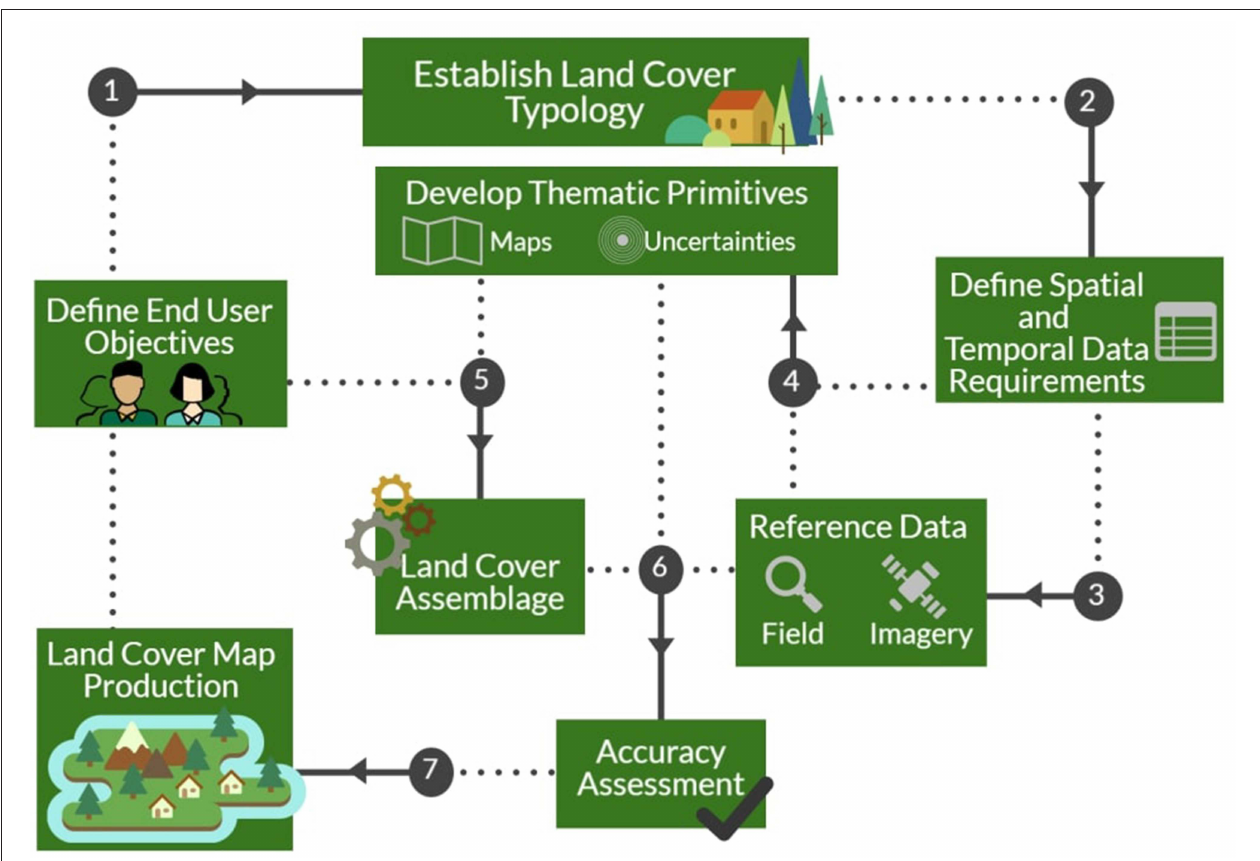
Figure 3 ). The final workshop culminated in the presentation